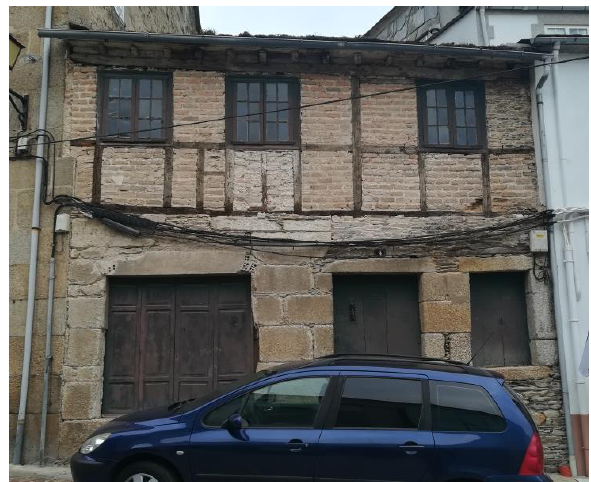
Figure 14. One of the examples of a medieval half-timbered house with brick filling and a stone ground floor that preserves the openings in the façade without modifying it. Source: